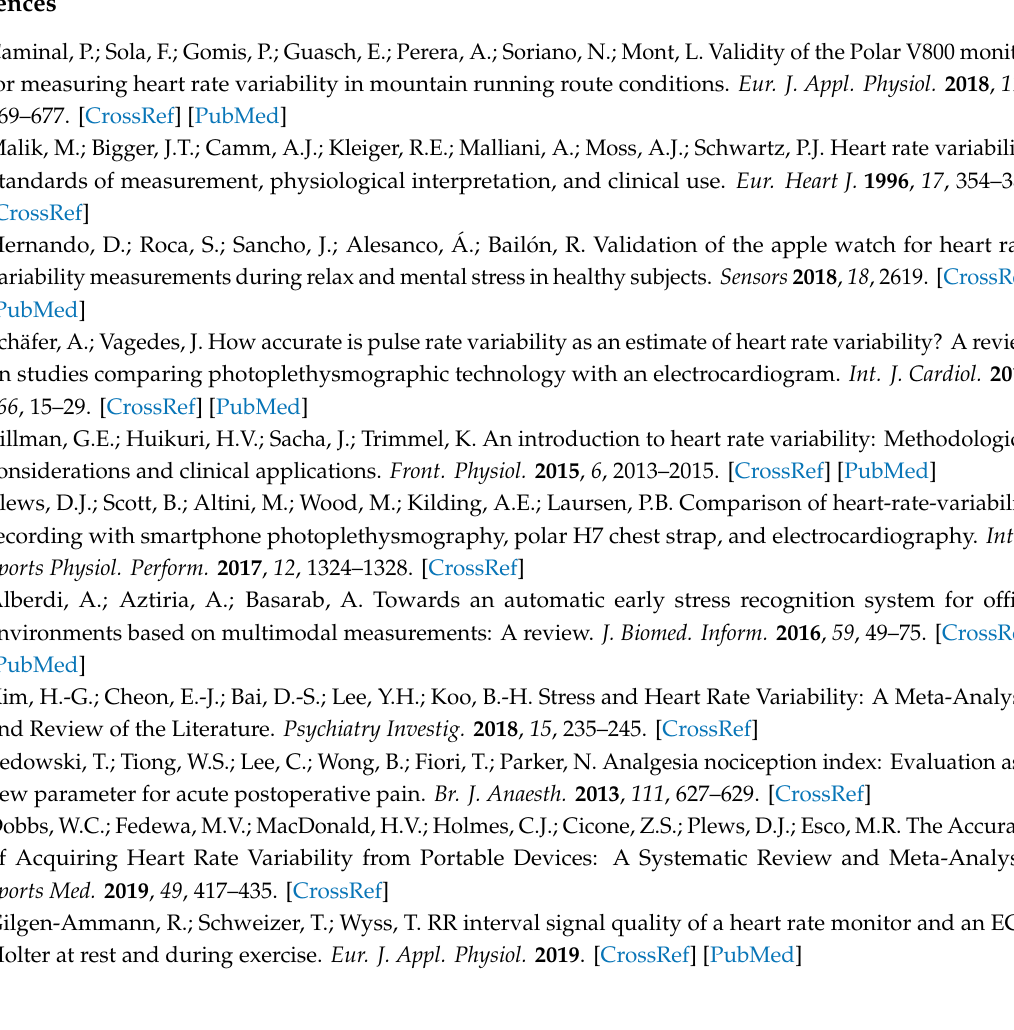
Figure A4. Bland–Altman plots for the pairs of frequency-domain and non-linear metrics obtained during the SCWT. The blue line and area represent the mean of the di ff erences between measurements and the associated confidence interval. The red lines and the associated area represent the upper and lower LoA and the associated confidence intervals.